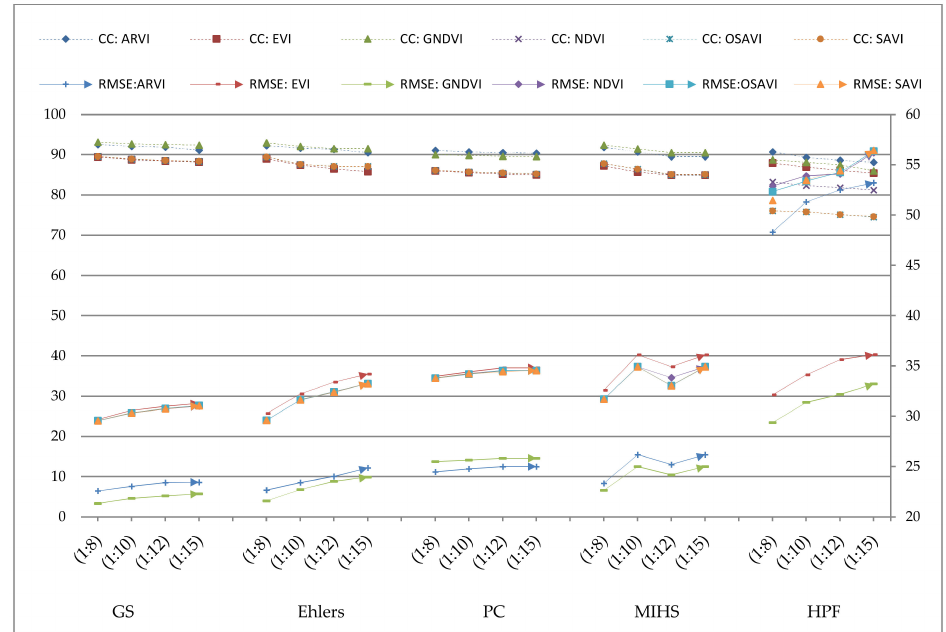
Figure 5. Trend of FVI quality with Image Fusion and SRR (Constant SRF and Good